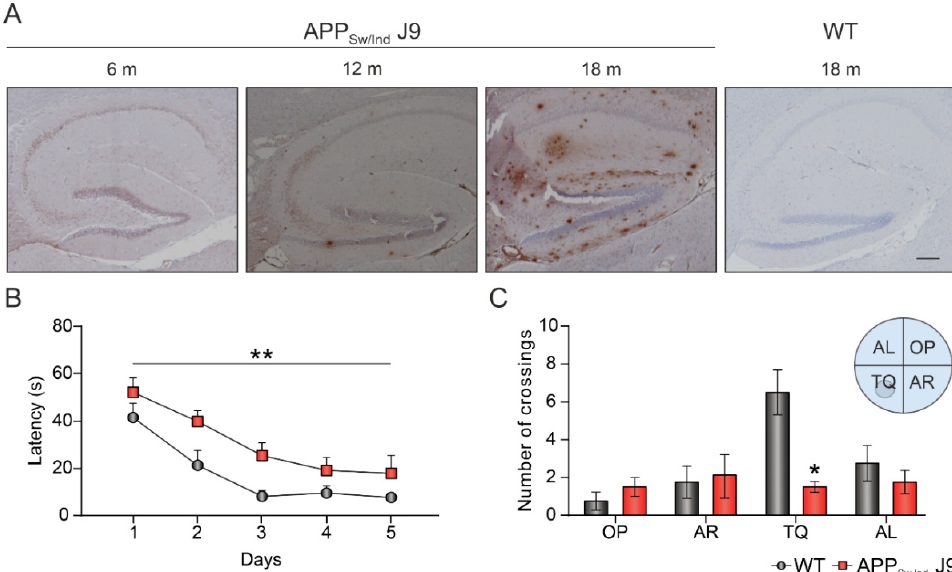
Figure 2. Age-dependent progression of amyloid pathology. ( A ) Age-dependent amyloid accumulation in the hippocampus of APP Sw,Ind J9 mice at 6, 12 and 18 months of age. Brain sections were stained with an anti-A β 6E10 antibody. Scale bar: 250 µm. m, months; h, hours; WT, wild type. ( B ) Latency to find the hidden platform in the MWM during 5 days of training. Data is expressed as mean ± SEM. s, seconds. ** p < 0.01. ( C ) Number of crossings to the different quadrants during the memory test. Data is expressed as mean ± SEM. TQ, target quadrant; OP, opposite; AR, adjacent right; AL, adjacent left. * p < 0.05.